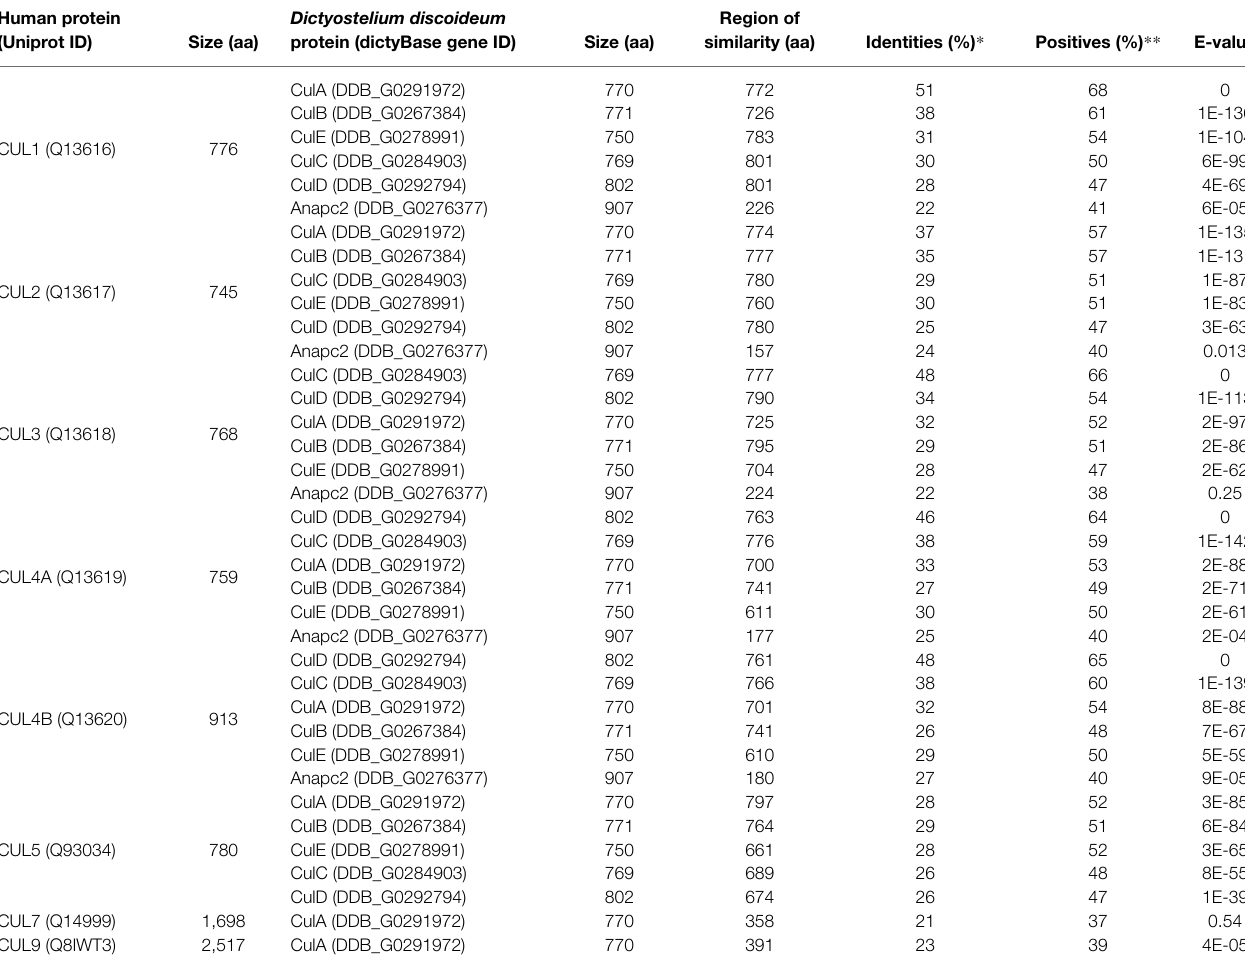
TABLE 2 | Sequence similarity between cullins in humans and Dictyostelium discoideum . Human protein (Uniprot ID) Size